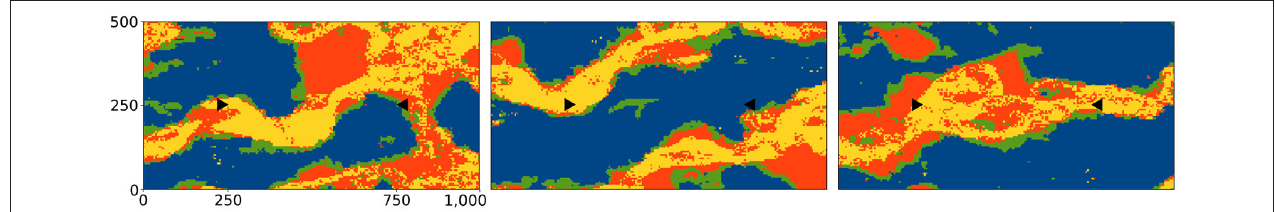
FIGURE 4 | Three random realizations from the PoPEx sampling. The above problem assigns a large likelihood value to the left, a very low likelihood value to the middle, and an average likelihood value to the right parameter map.